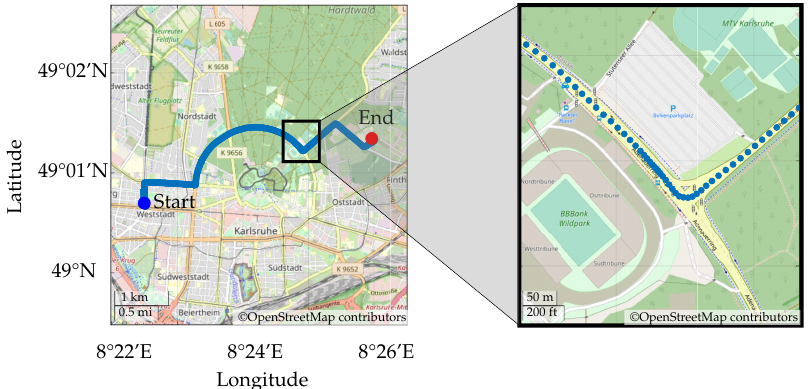
Figure 6. Visualization of available driving data.